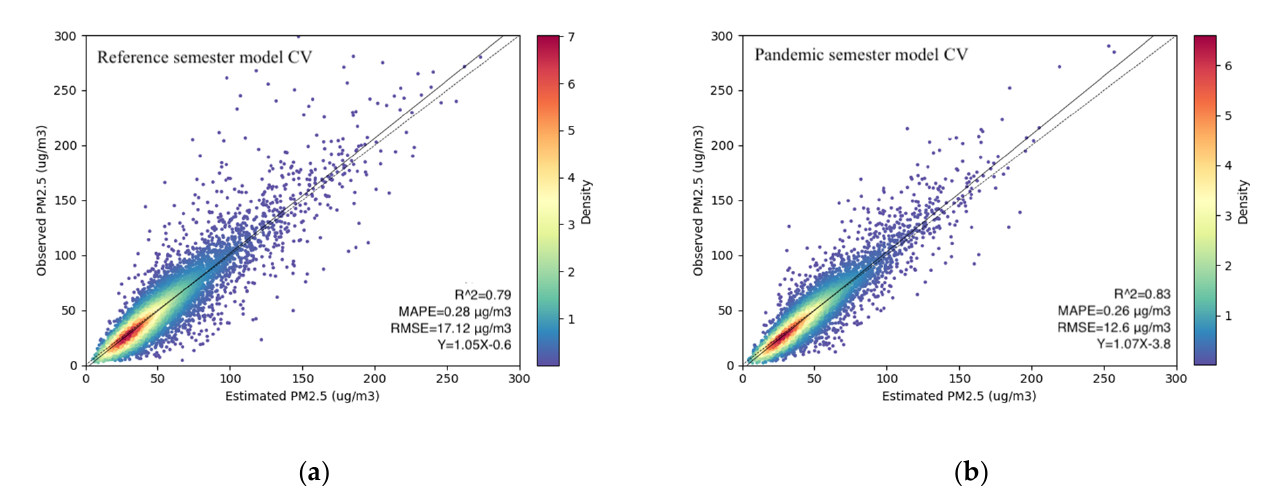
Figure 3. ( a ) Density plot of ground and monitored PM 2.5 measurements in µ g/m 3 based on the 10-fold cross-validation of the reference semester model; ( b ) density plot of ground and monitored PM 2.5 measurements in µ g/m 3 based on the 10-fold cross-validation of the pandemic semester model.